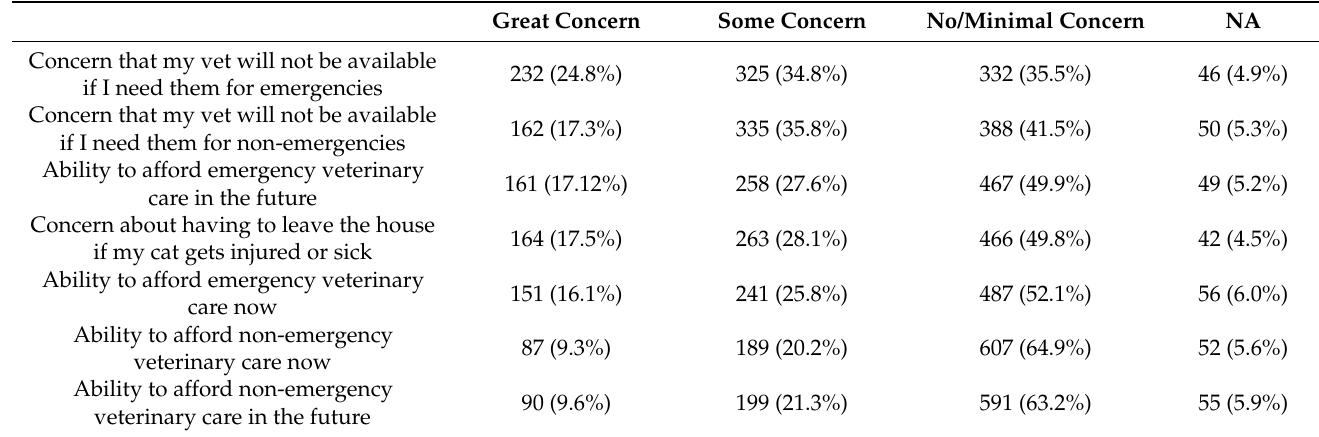
Table 2. Stated concern for veterinary